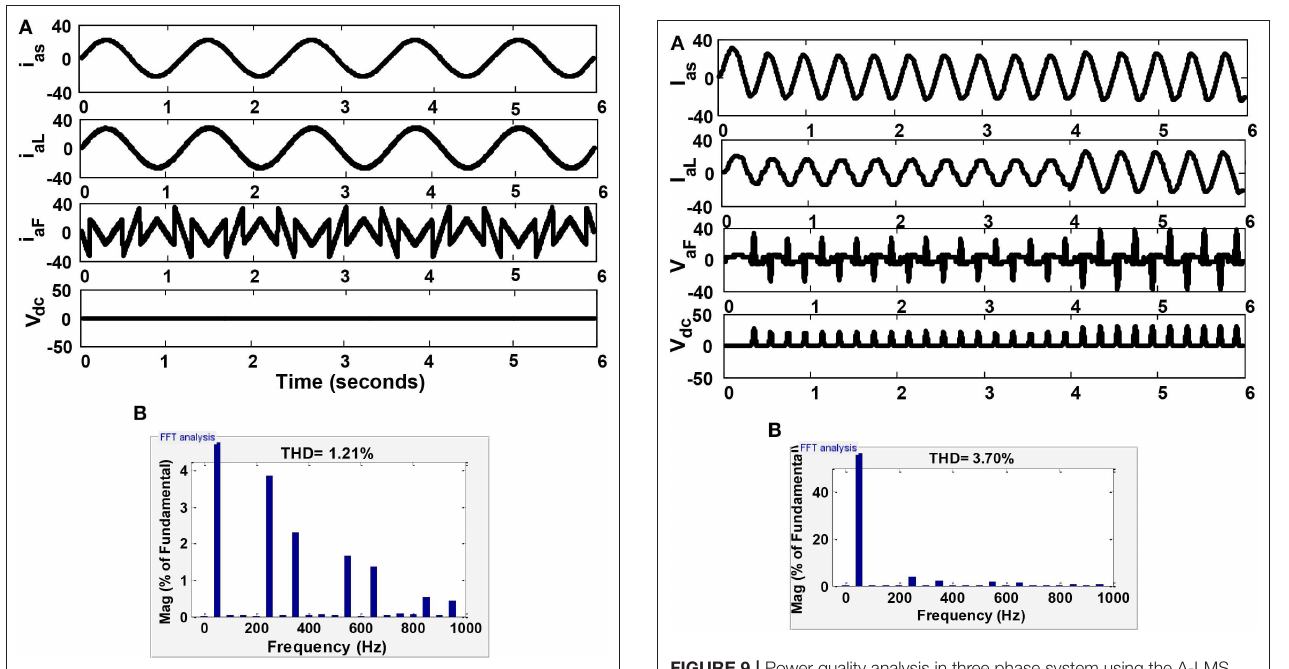
FIGURE 7 | Power quality analysis in three-phase system using the A-LMS algorithm under balanced load conditions: (A) simulation results showing supply current, load current, filter voltage, and DC-bus voltage; and (B) THD value of 1.21%.